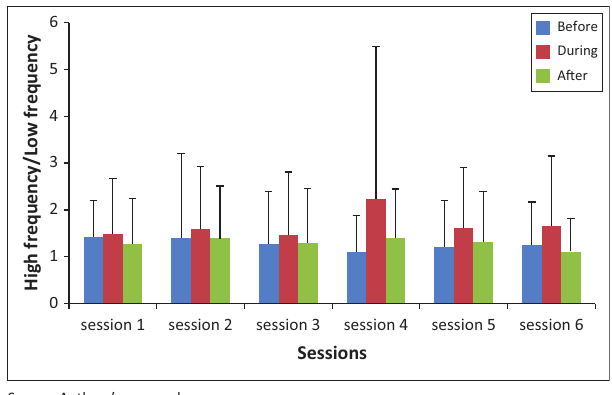
FIGURE 5: LF/HF before, during and after therapeutic horseback riding (THR) over six